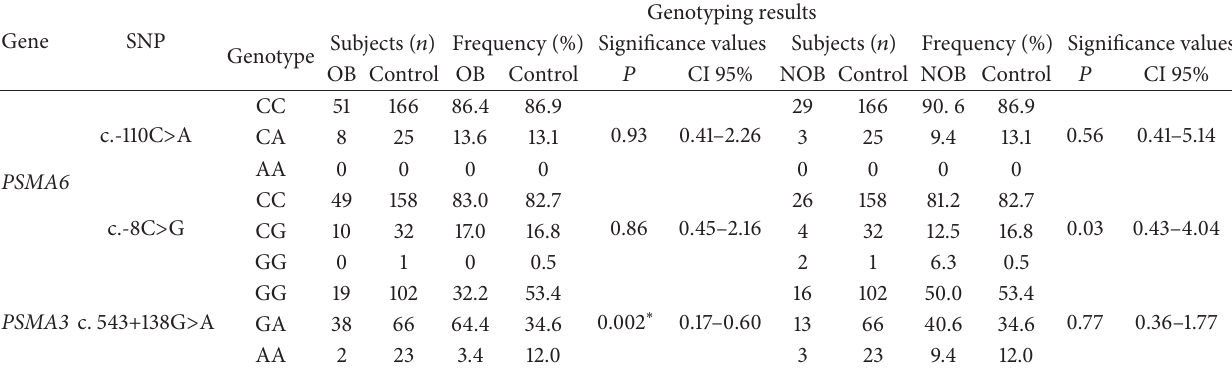
Table 4: Genotype frequencies in obese children with (OB) and without (NOB) a family history of obesity.